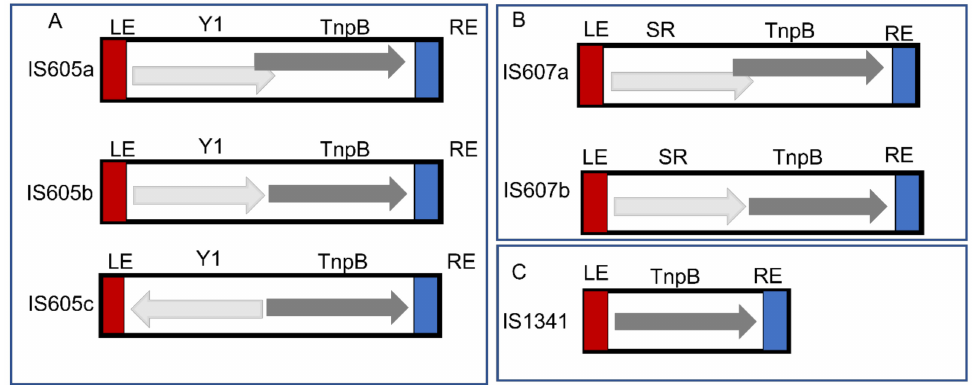
Figure 1. Structure organization of TCME elements. ORFs are presented as boxes with arrowheads showing the direction of transcription: LE and RE are red and blue boxes, respectively. ( A ) Three genetic structures of IS605 elements. ( B ) Two genetic structures of IS607 elements. ( C ) Genetic structure of IS1341